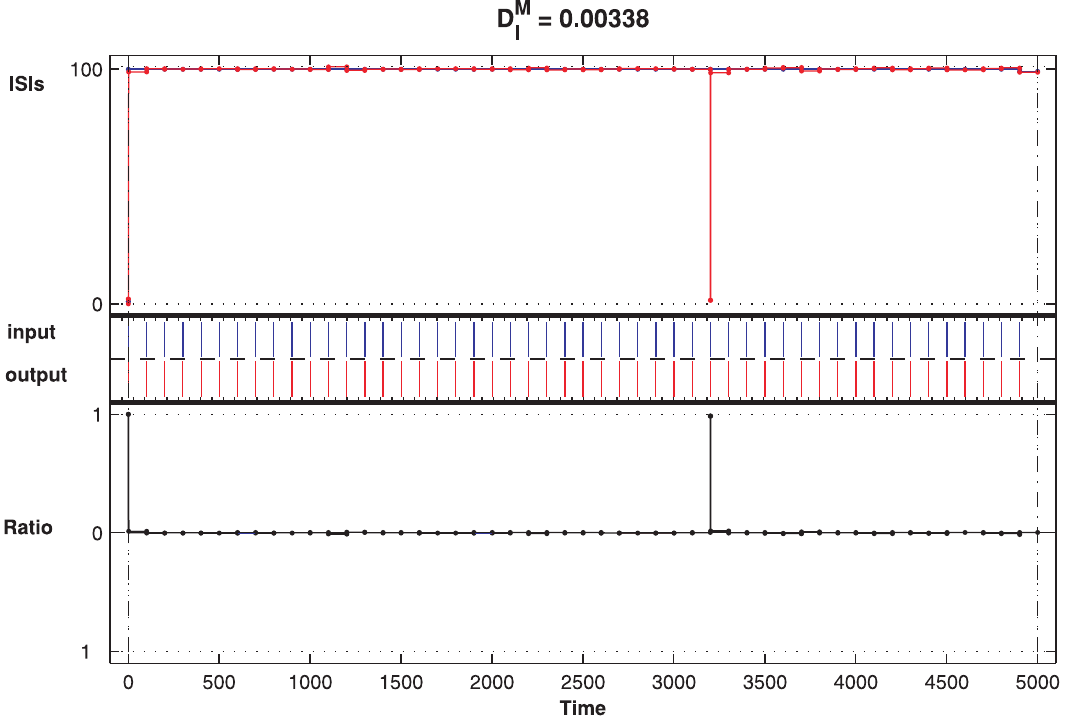
Figure 6. CD neuron with modulated state performs one to one locking. The detected output spikes are marked in red and the blue is the input. The top panel depicts the ISI-distance and the bottom one is the corresponding renormalized ISI-distance. For this pair of spike trains, T w ~ 2 : 0 ~ 0 : 00338 . The other parameters for the input and the LIF neurons are the same as in Figure 3. ms and h ~ 25 , and the ISI-distance is D s M